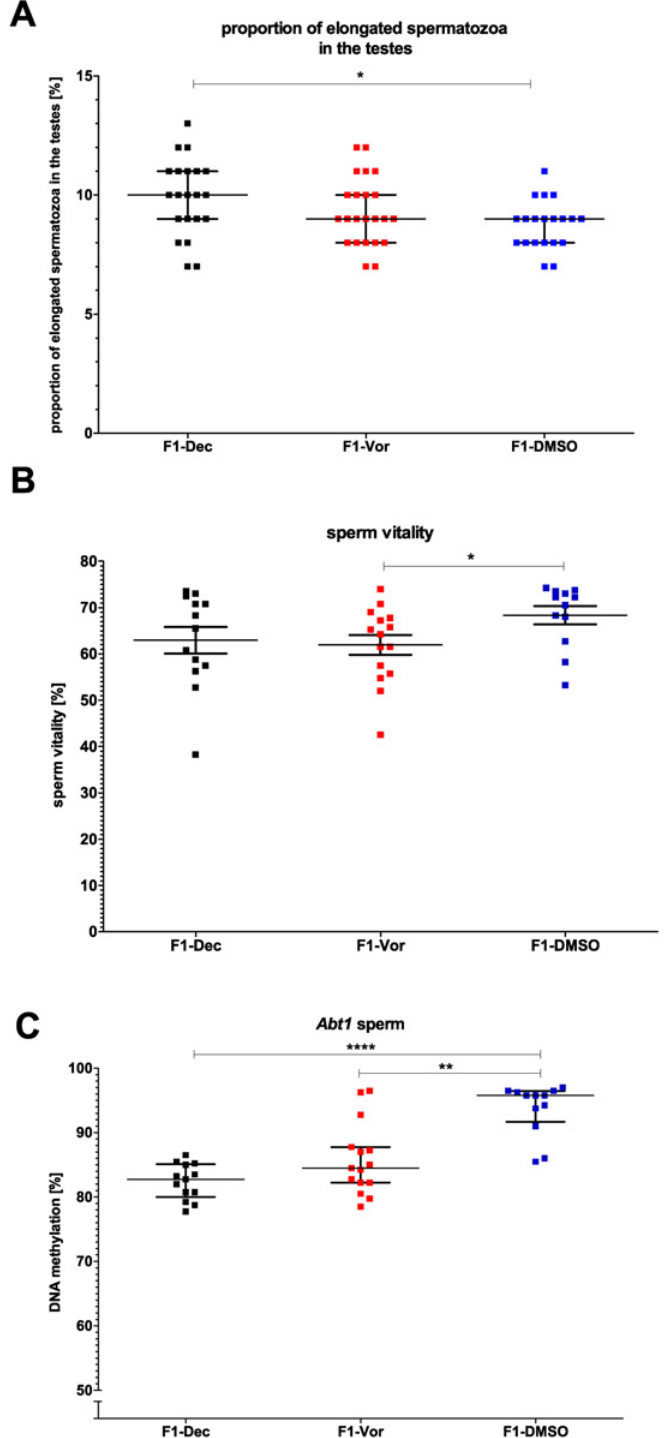
Fig 5. Effects of treatment in the F1-generation. A) Proportion of elongated spermatozoa (cells with highly condensed DNA) in the testes, B) sperm vitality and C) DNA methylation of Abt1 in spermatozoa. Statistical differences were calculated for decitabine and vorinostat in comparison to DMSO vehicle control. One point represents one animal. A, C) The median ( ± interquartile range) or B) the mean ( ± SEM) are shown for each group, * : p < 0.05, ** : p < 0.01, *** : p < 0.001, **** : p <